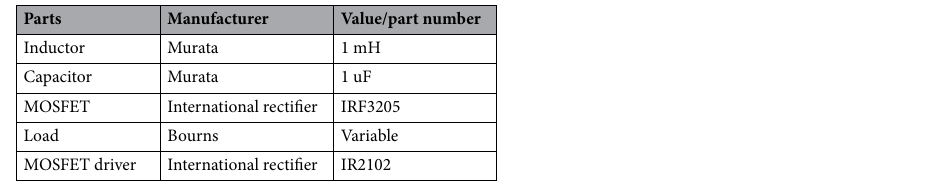
Table 3. List of components for buck convertor.